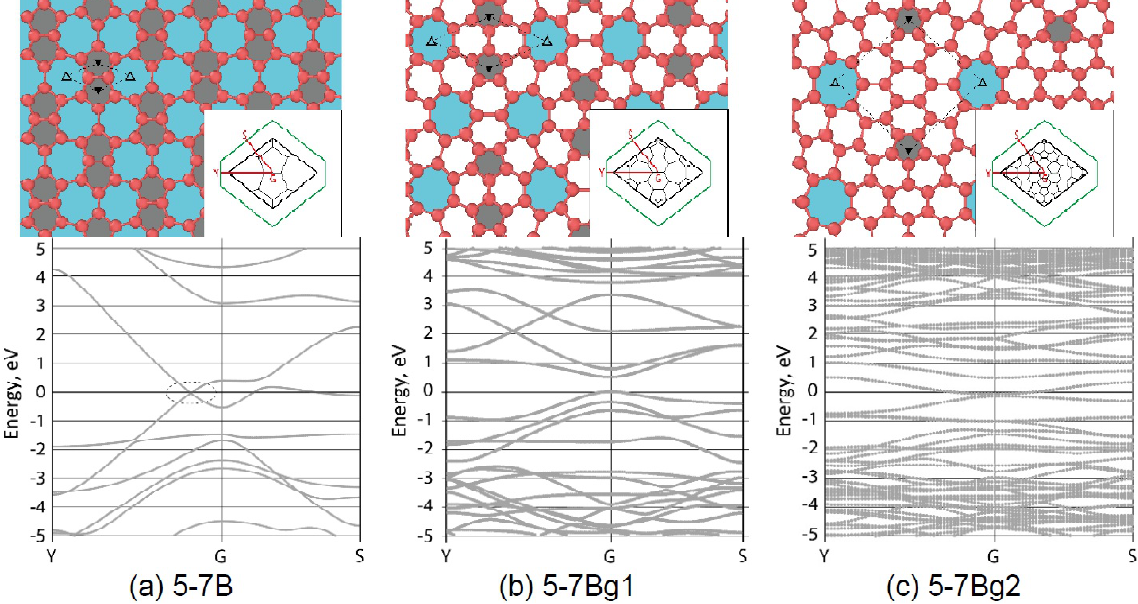
Fig. 4. Pseudo-graphenes designed by disclination networks and their band structures. In crystal lattices, the disclination quadrupoles are depicted, and the insets show Brillouin zones. Pseudo-graphenes are marked with 5-7B, 5-7Bg1, and 5-7Bg2. In band structure of 5-7B (a), Dirac cone in (a) is outlined by dashed ellipse.